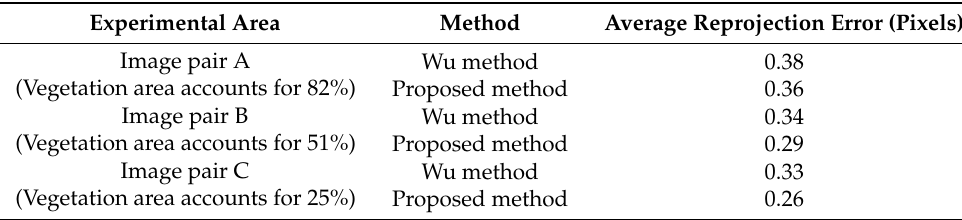
Table 5. Statistical results of the average reprojection errors in three image